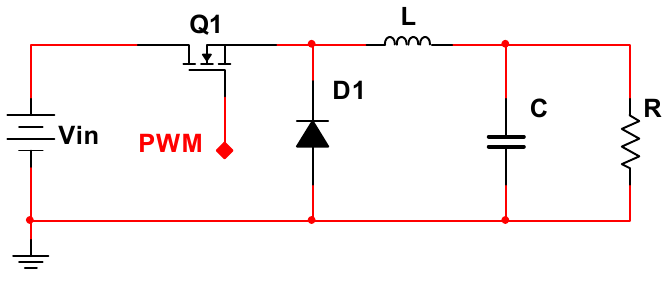
Figure 6. Buck converter [8].